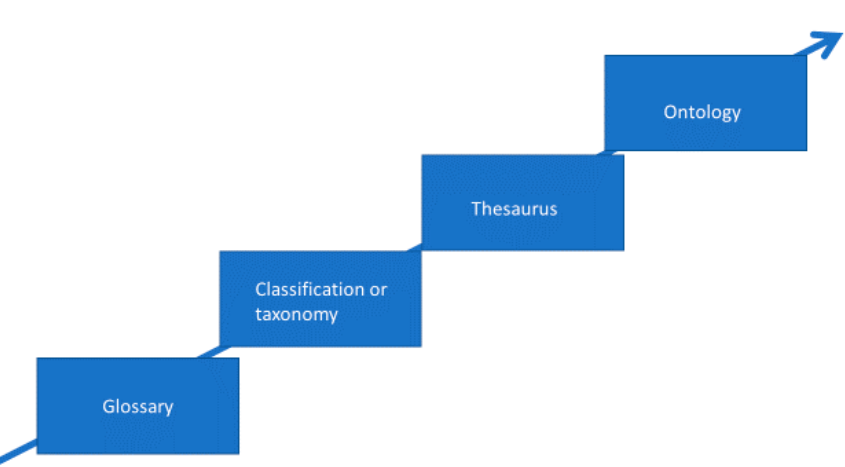
Figure 1. The Semantic staircase: Increasing semantic richness in kinds of knowledge organization systems (after [44]).